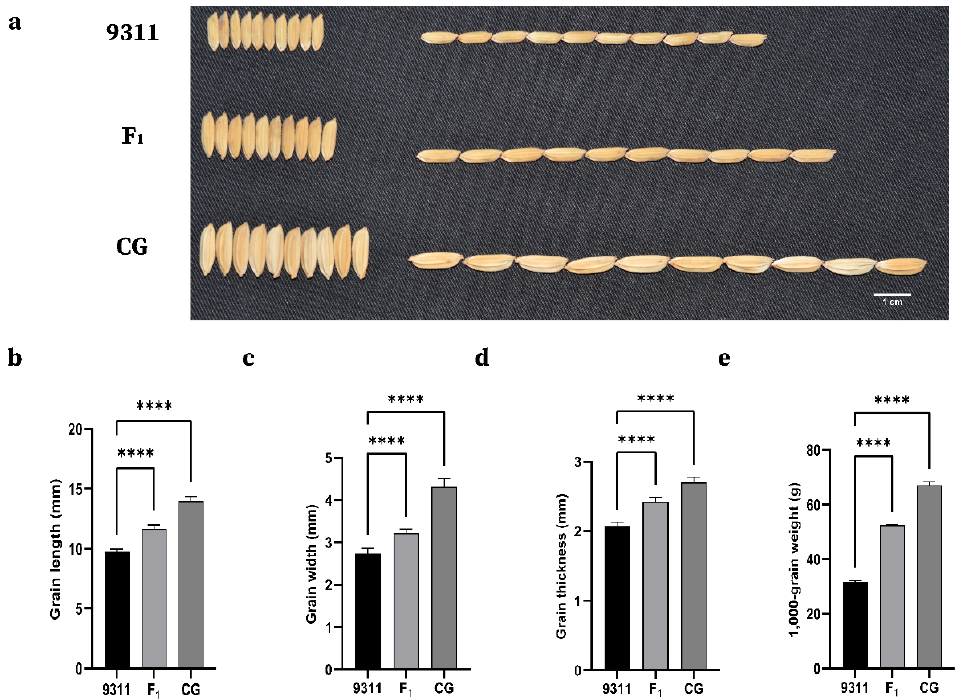
Figure 1. Grain size of two parents and F 1 individuals derived from the cross between CG and 9311. ( a ) Grain phenotypes of 9311, F 1 , and CG, Bar, 1 cm. ( b – e ) Grain length, width, thickness, and 1000-grain weight of 9311, F 1 , and CG. Student’s t -test was used to generate p values; **** p < 0.0001.